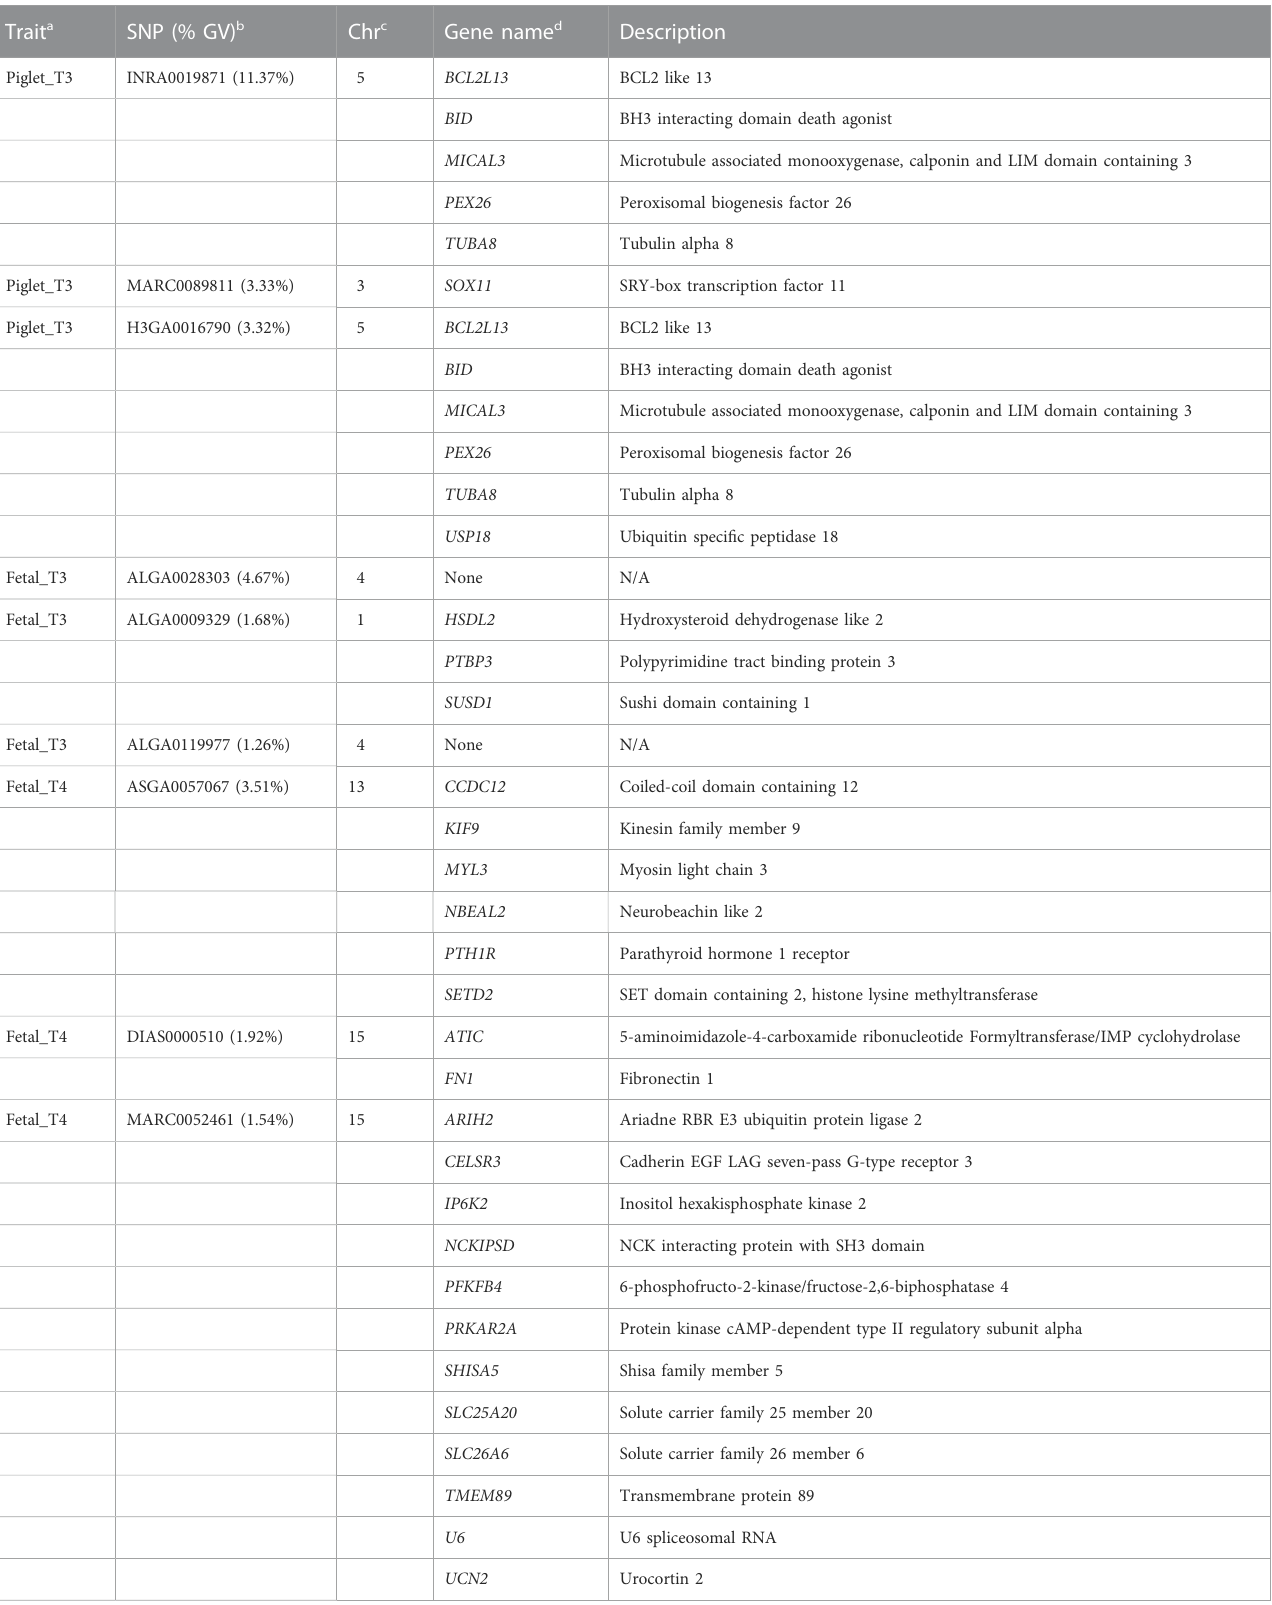
TABLE 5 Positional candidate genes for the top SNP based on percentage of GV explained for each trait. Trait